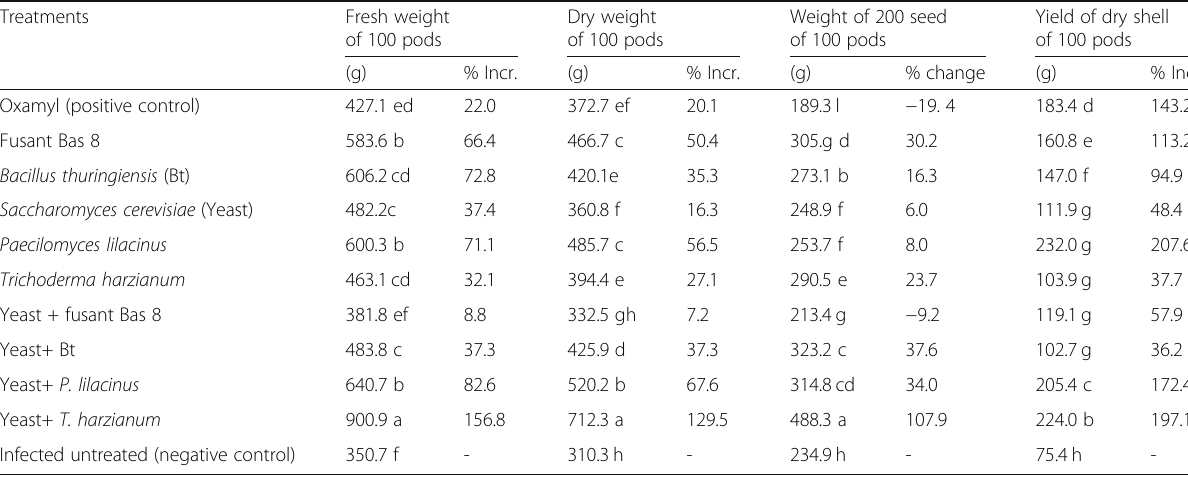
Table 4 Growth parameters of peanut plant infected by M. javanica and treated with fusant Bas 8, Bacillus thuringiensis , Saccharomyces cerevisiae , Paecilomyces lilacinus , Trichoderma harzianum , and oxamyl under field conditions